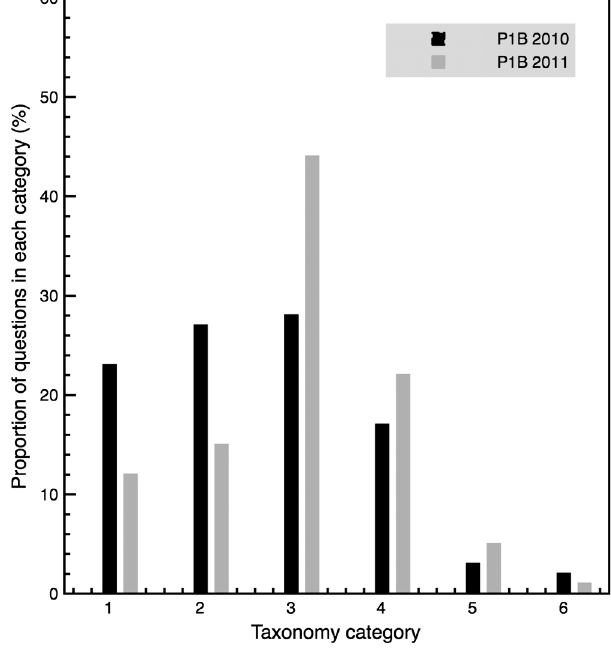
FIG. 1. Proportion of questions in each taxonomic category, for Physics 1A question repositories for 2010 ( N ¼ 150 , dark bars) and 2011 ( N ¼ 200 , light bars).